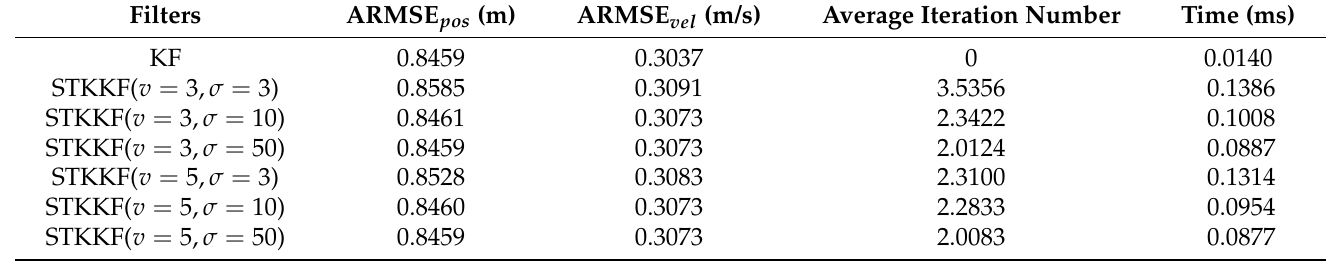
Table 1. ARMSEs of position and velocity, average iteration numbers, and average implementation times for one time step of the proposed STKKF and KF when both the process noise and measurement noise are Gaussian noises.